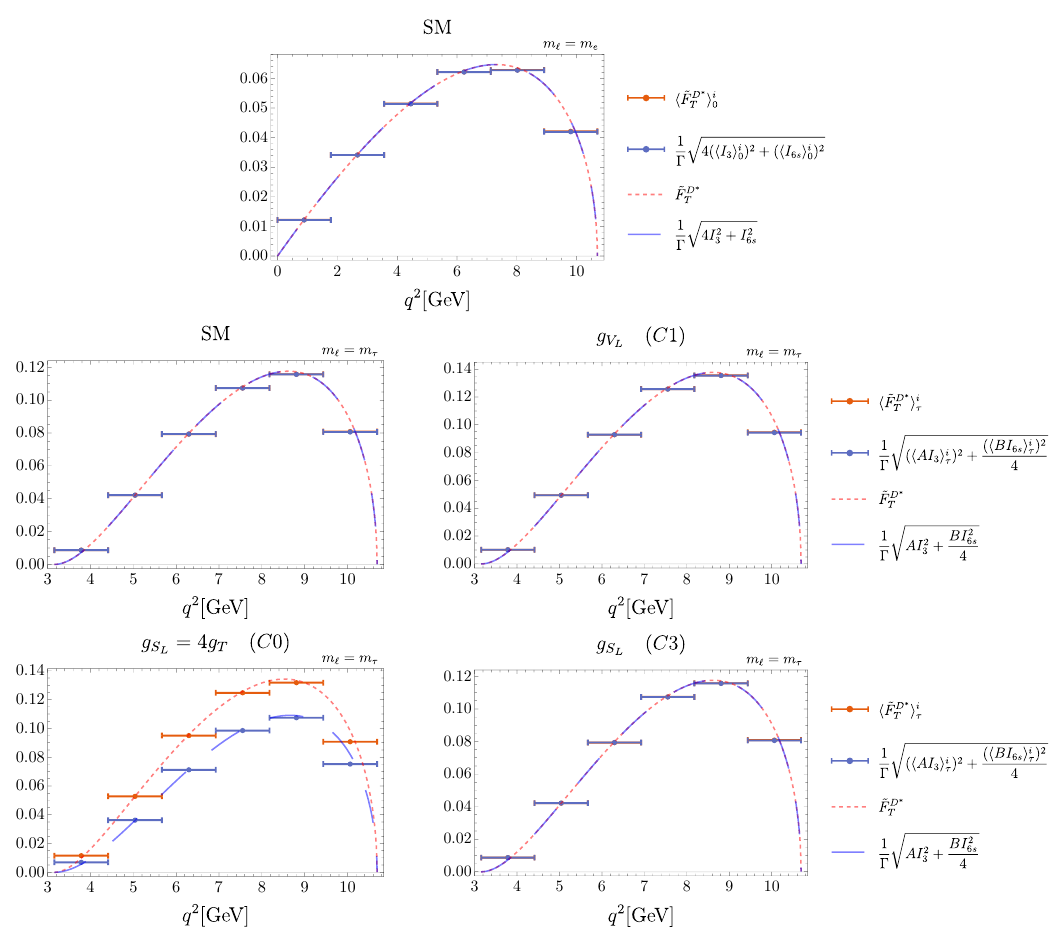
Figure 3. Same as (cid:12)gure 1 for eq. (4.18).